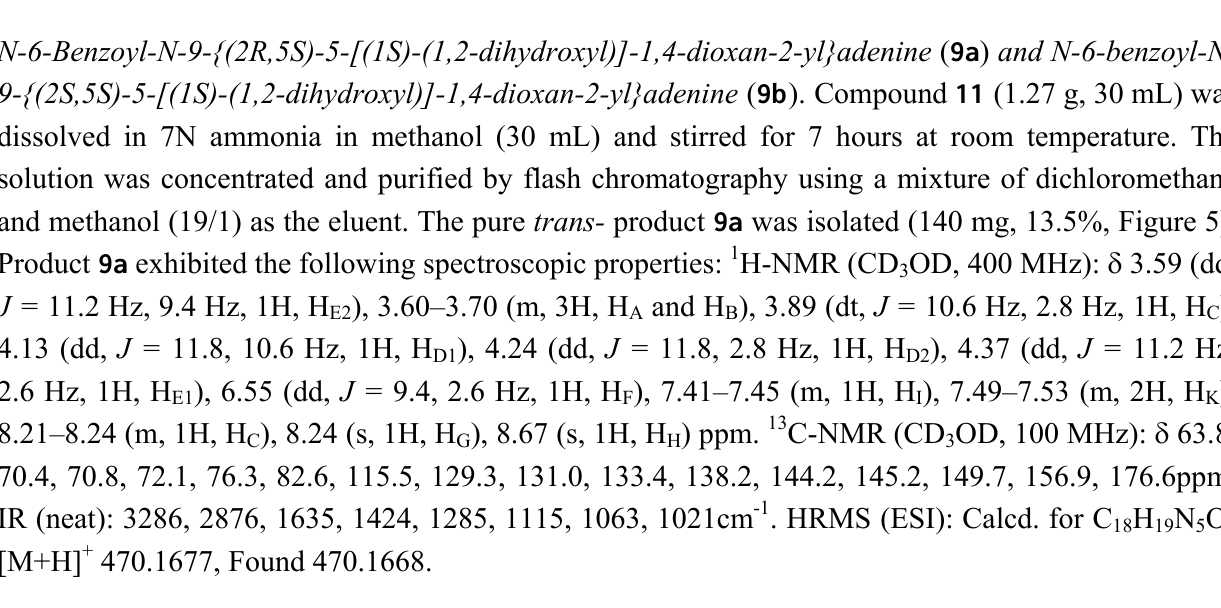
Figure 5. Structure of compound 9a